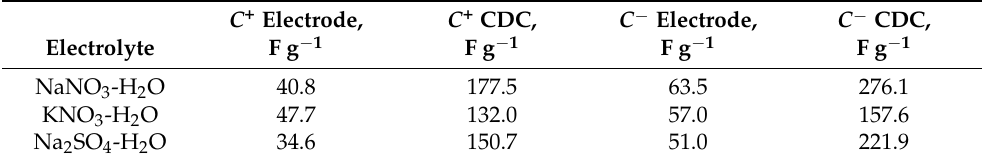
Table 3. Gravimetric capacitance values for positively and negatively charged electrodes evaluated by CC tests at a current density of 0.5 mA cm − 2 in 1 M